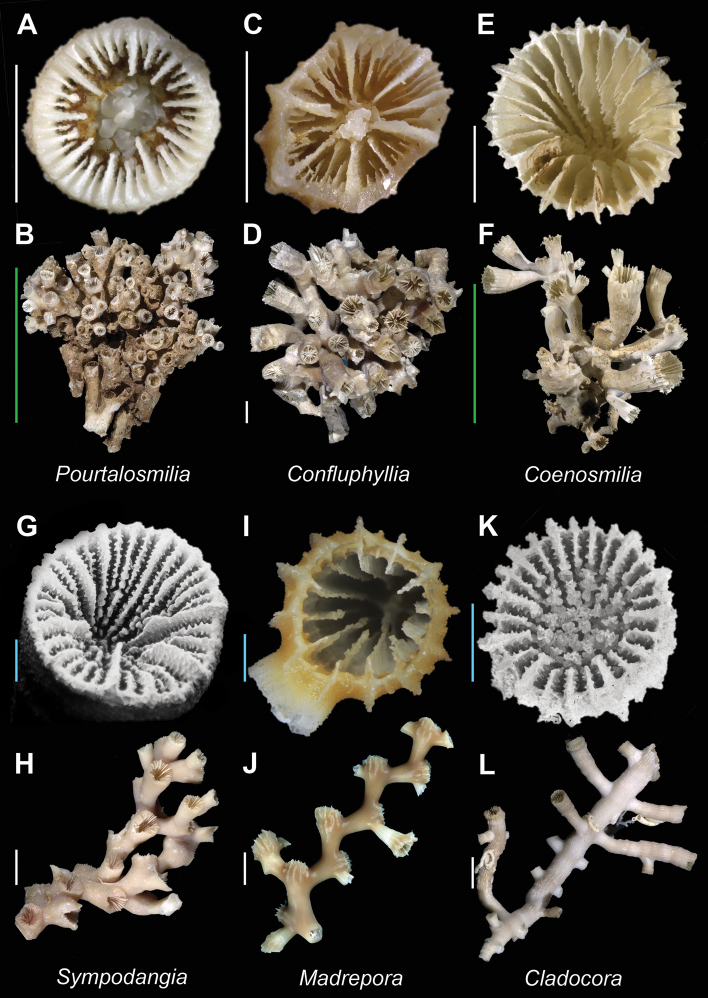
Pourtalosmilia anthophyllitesA (USNM 1174947) and B (USNM 117494): Calicular and colony view respectively; Confluphyllia juncta(USNM 97316, paratype) C and D Calicular and colony view respectively; Coenosmilia arbuscula(USNM 97312) E and F Calicular and colony view respectively; Sympodangia albatrossi (USNM 97308, holotype) G (SEM) and H Calicular and colony view respectively; Madrepora oculata(MNHN uncatalogued, Halipro 2 stn. BT104) I and J Calicular and colony view respectively; Cladocora debilis
K (USNM 10452, SEM) and L (USNM 62351): Calicular and colony view respectively. Scale bars: blue = 1 mm; white = 5 mm; green = 50 mm. Bold face indicates type species for the genus.